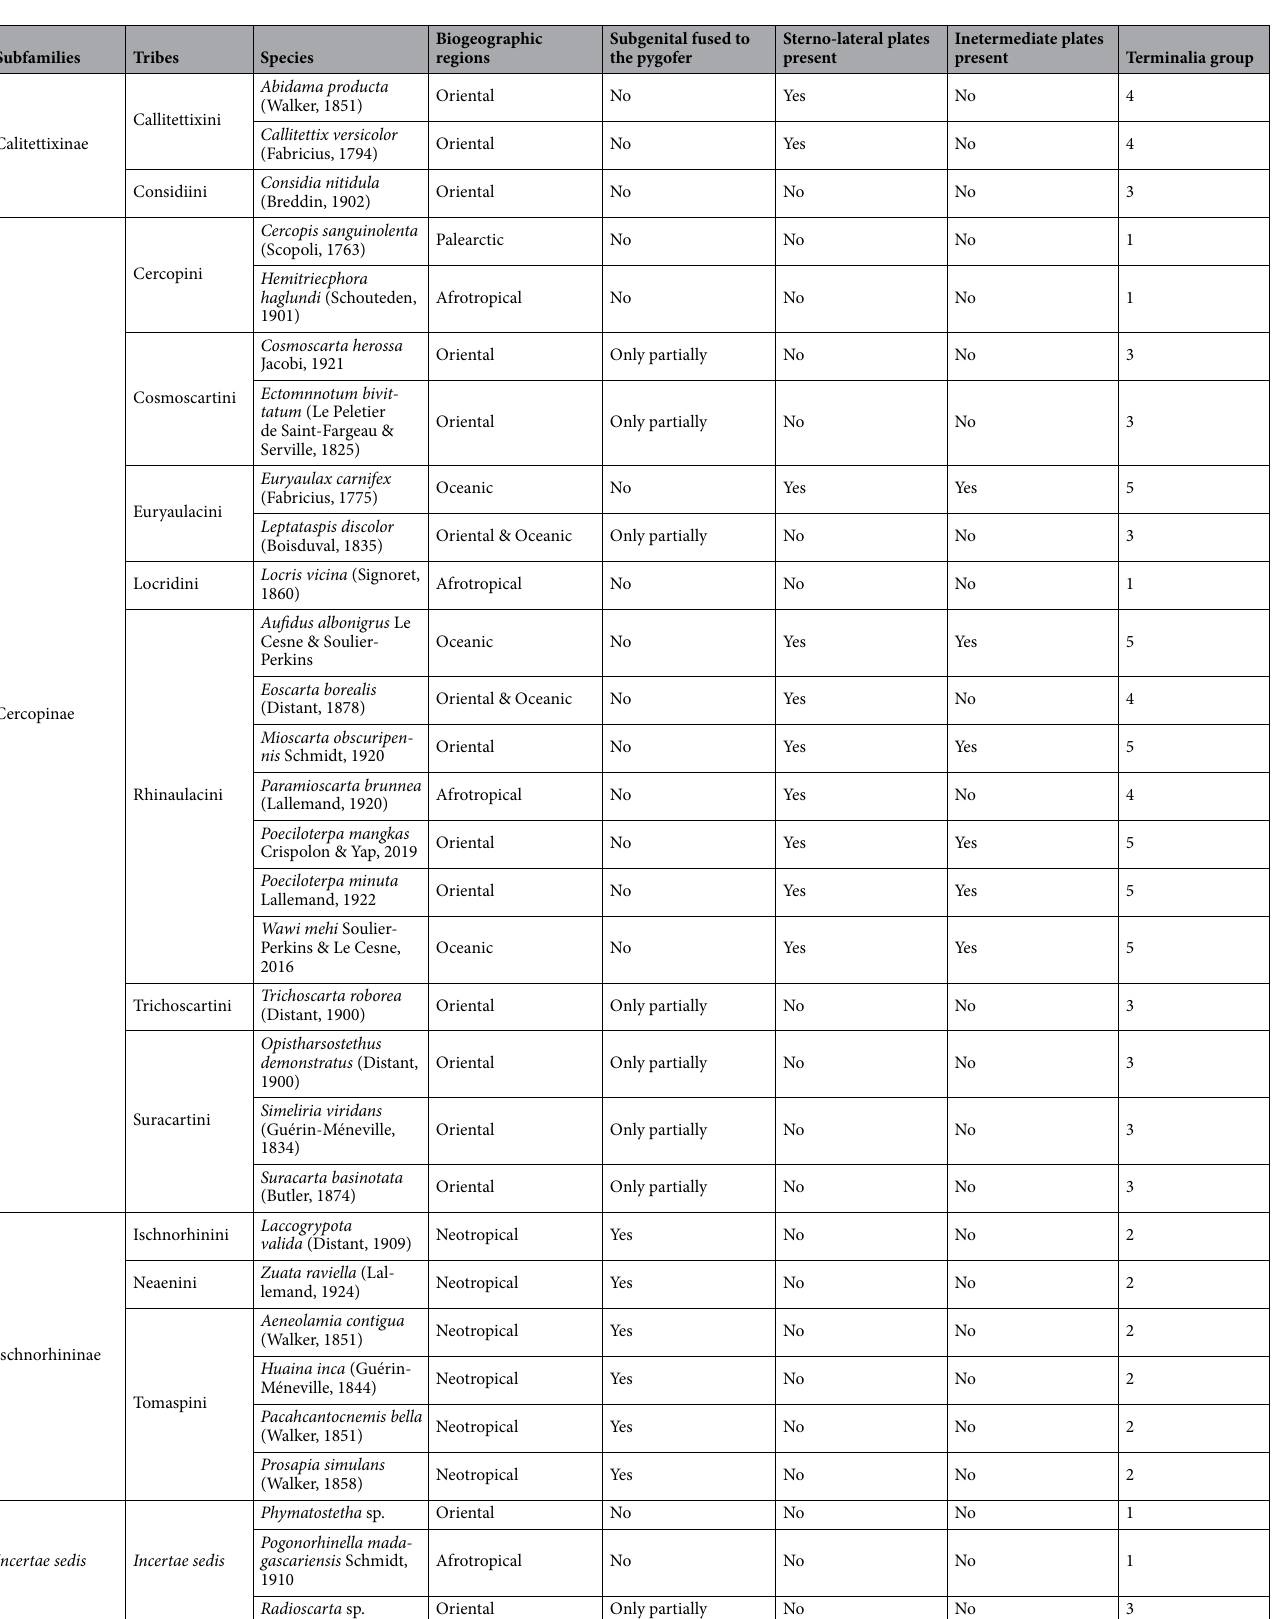
Table 2. Species studied with the subfamily, tribe, biogeographical region and terminalia group to which they